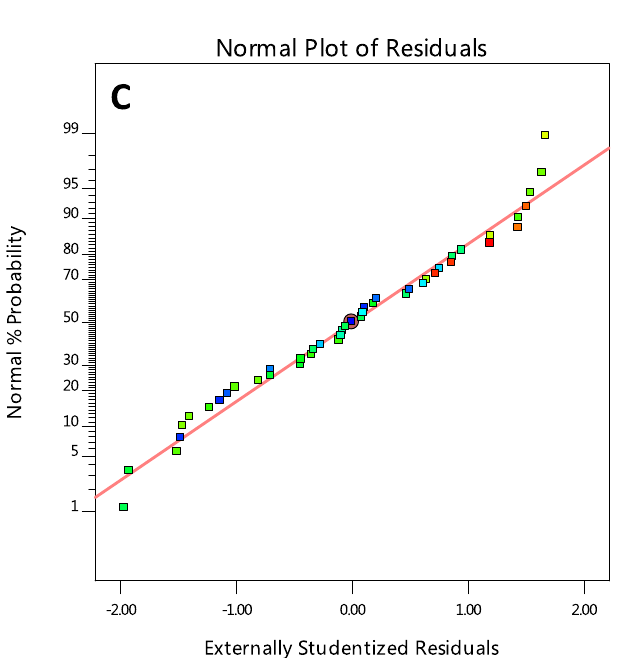
Figure 10. Normal probability plots of residuals for ( A ) wear rate, ( B ) specific wear rate, & ( C ) wear